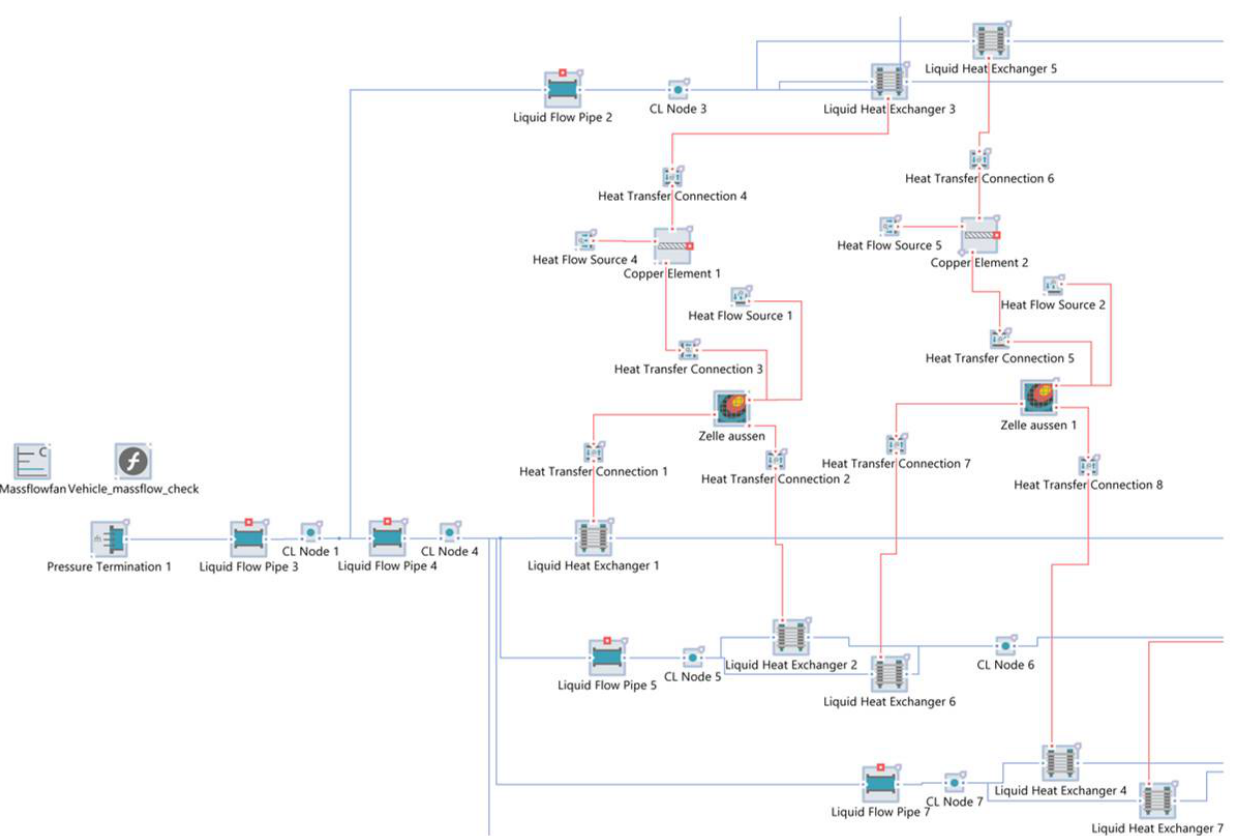
Figure 7 . Section of the model of the battery with integrated air cooling.